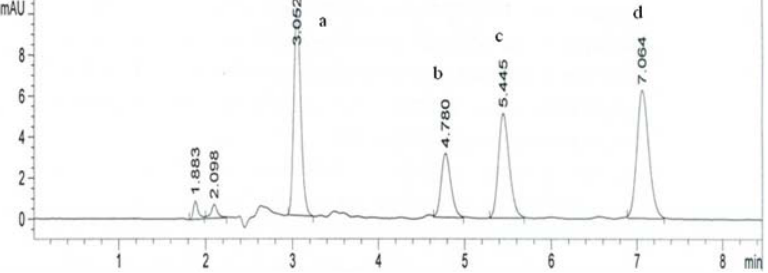
Figure 5. LC-PDA chromatogram of para- hydroxyatorvastatin ( a ), ortho- hydroxyatorvastatin ( b ), atorvastatin ( c ) and atorvastatin lactone ( d ) taken under optimized experimental conditions.